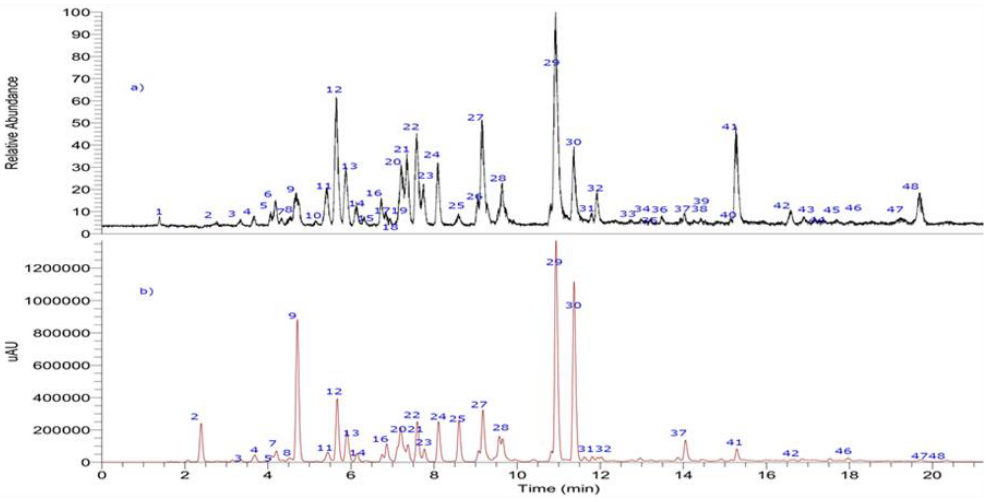
Figure 1. UHPLC-MS (total ion current) chromatograms of ZpRe resin.